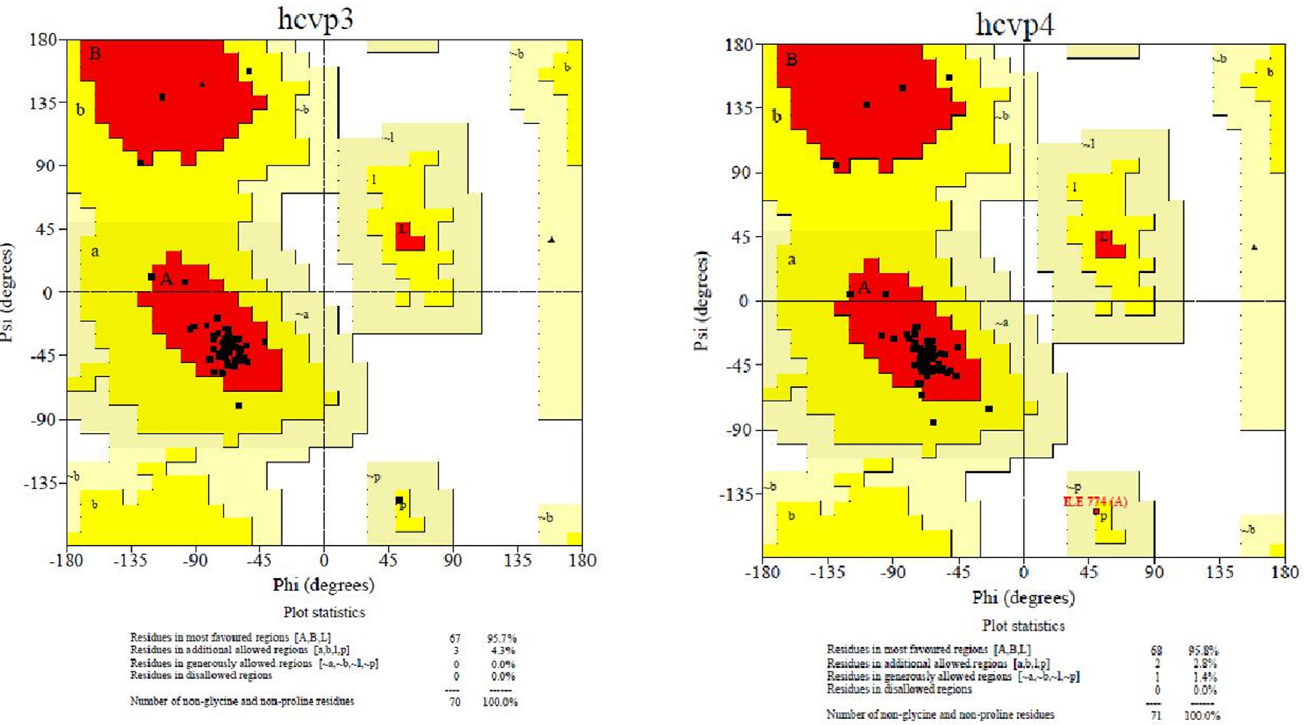
Fig 3. Ramachandran plot of model p7 from GT3 and GT4 plotted between pi and psi angles of all amino acids. Areas defined as red, yellow, light yellow and white indicate most favored, additional allowed, generously allowed and disallowed regions, respectively.